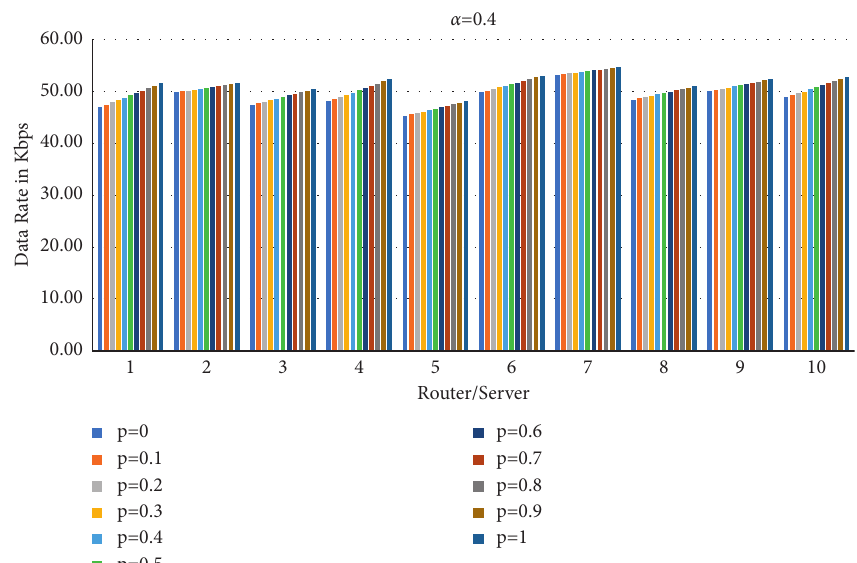
Figure 6: Graphical representation of data stream rate when α � 0 .